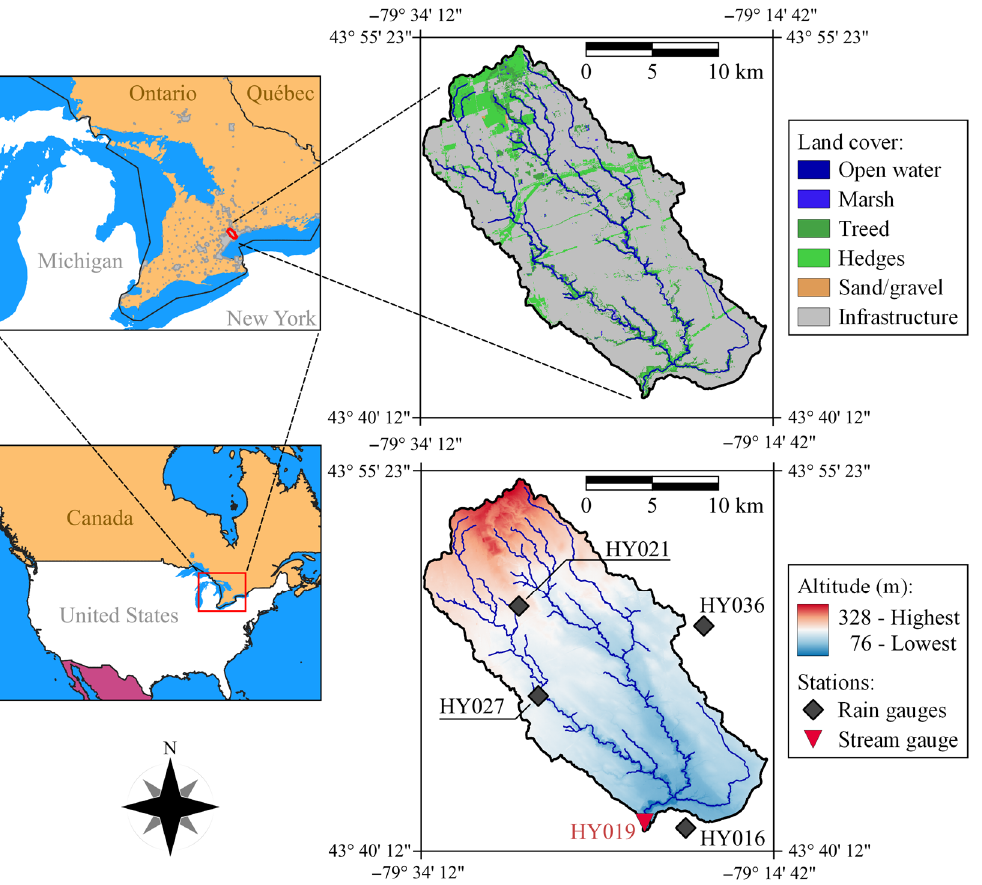
Figure 1. Location, landcover and elevations of the Don River basin with the rain and stream gauges used in this work.